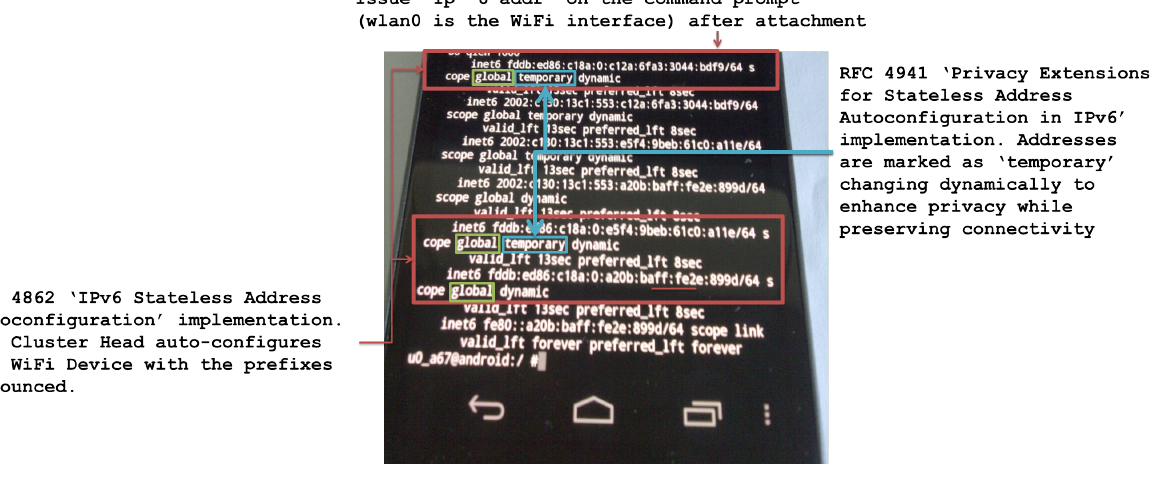
Figure 11. Android Cluster Head connected to the MR. The Request for Comments (RFC) 4941 privacy extension IPv6 addresses are used to issue connections towards the personal health record (PHR). This is a privacy-related precaution completed by the use of a secure SSL connection on the application